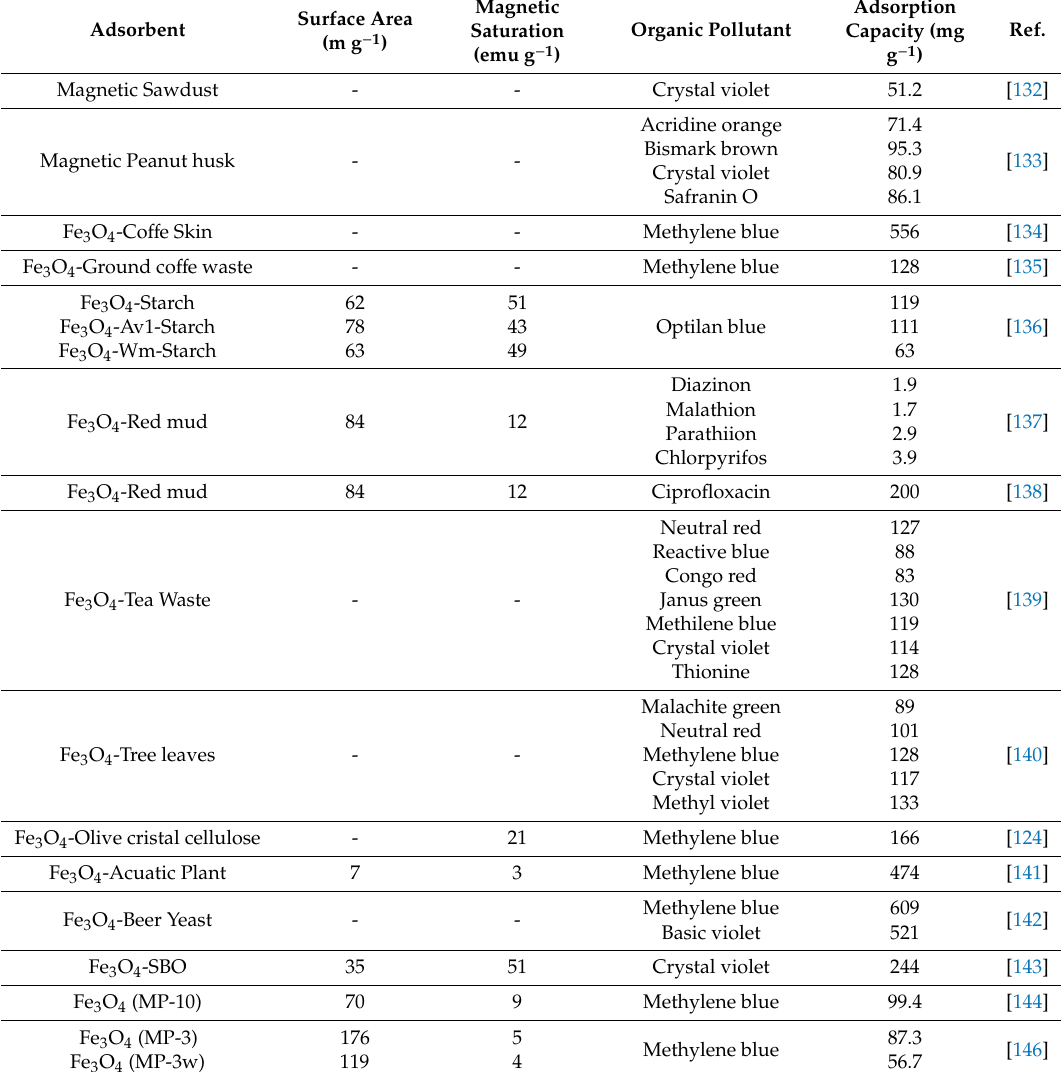
Table 5. Application of magnetic waste-based nanoadsorbents for organic pollutants removal from